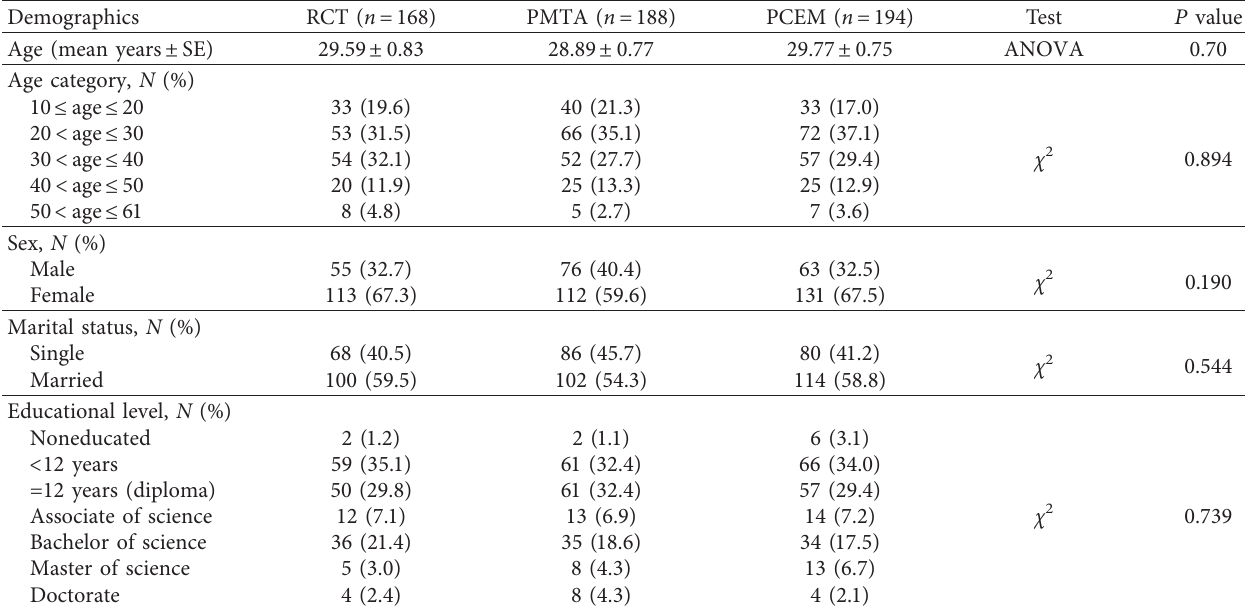
Figure 1: CONSORT flow diagram of participants through each stage of randomized clinical Table 1: Comparison of patient demographics in the three study arms.